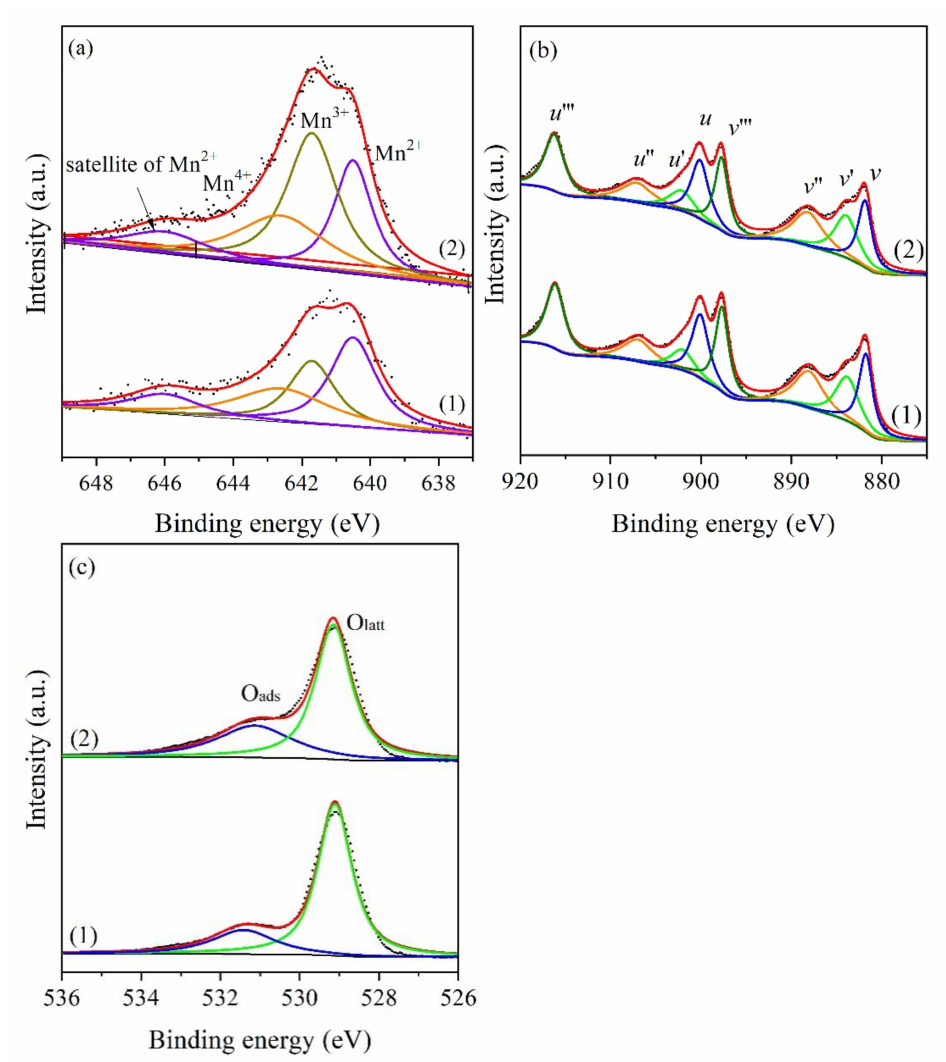
Figure 3. XPS spectra of ( a ) Mn 2 p 3/2 , ( b ) Ce 3 d and ( c ) O 1 s on (1) MnCe-L and (2)